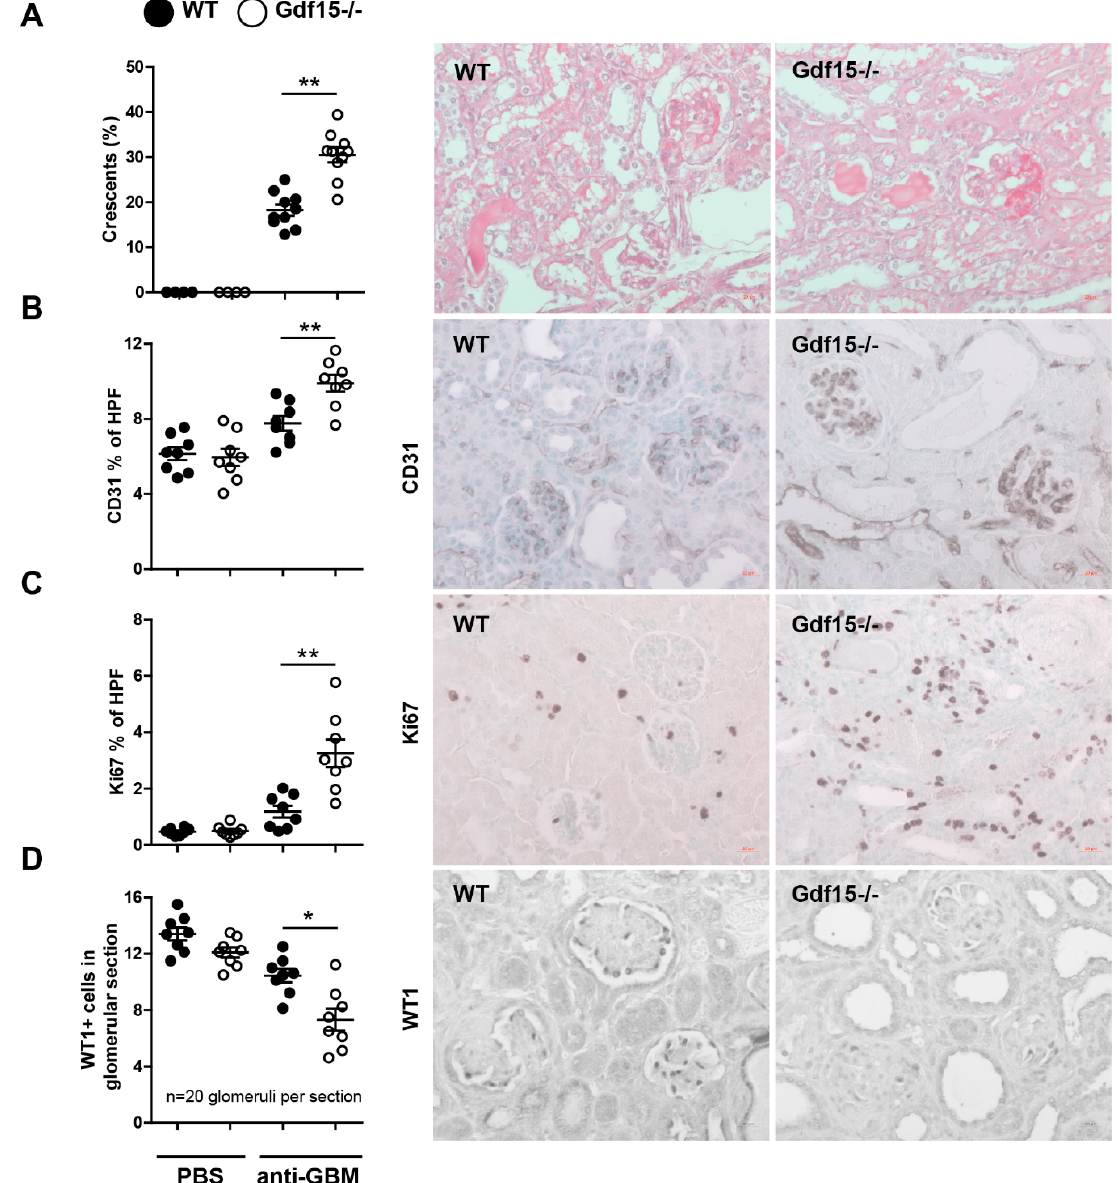
Figure 3. Kidney histopathology of anti-GBM nephritis. Sections were obtained from wild type or GDF15-deficient C57BL/6 mice on day 14 after saline or antiserum (anti-GBM) injection. Kidneys from WT or KO mice were paraffin-embedded and stained either with ( A ) PAS, ( B ) anti-CD31 antibody, ( C ) anti-ki67 antibody and ( D ) anti-WT1 antibody, and quantified ( n = 8 mice per group, one-way ANOVA). Representative images of renal sections (original magnification 400×). Data are mean ± SEM. * p < 0.05; ** p < 0.01.